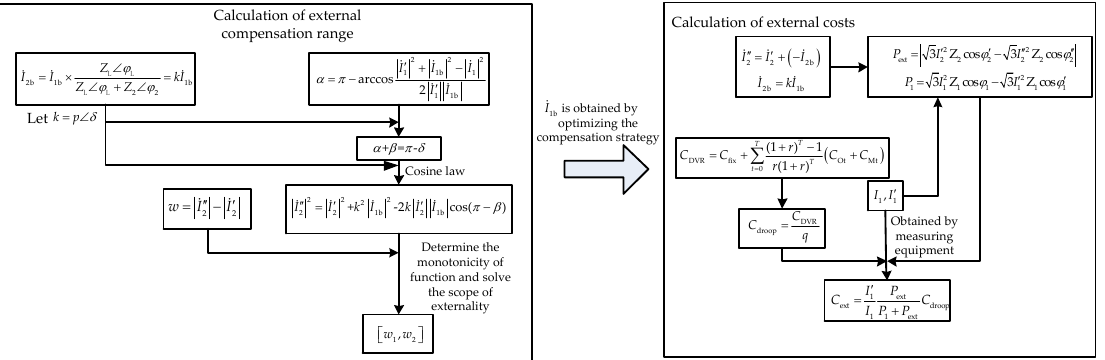
Figure 11. The calculation flow chart of the calculation model.